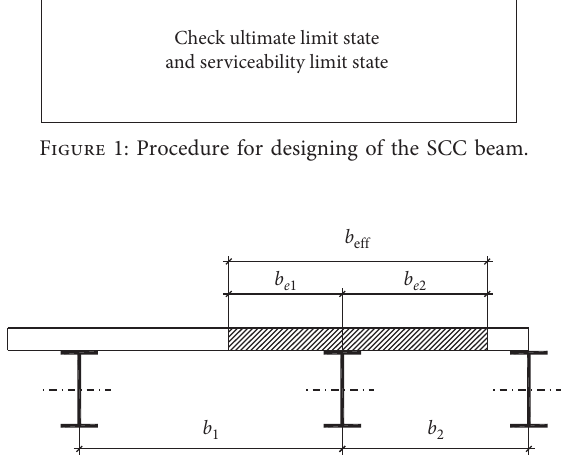
Figure 2: Procedure for designing of the SCC